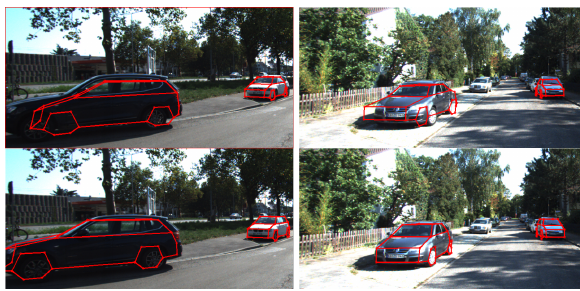
Figure 7. Results of 3D+Free (first row) and Refine (second